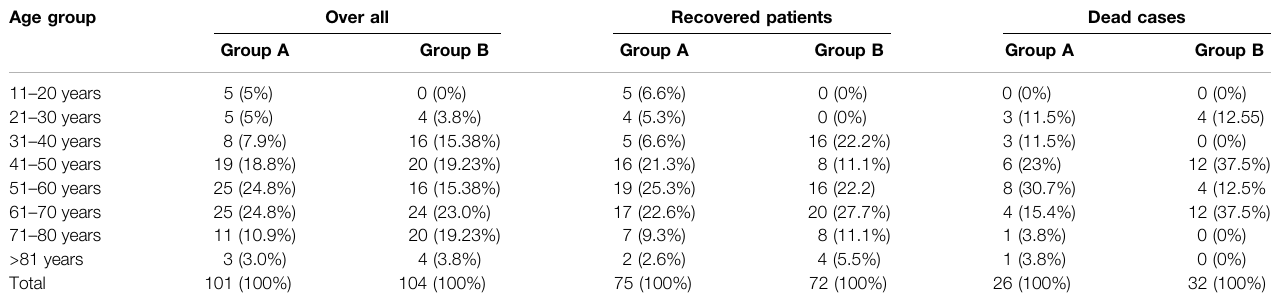
TABLE 4 | Subgroup analysis of the study group patients according to the age. Age